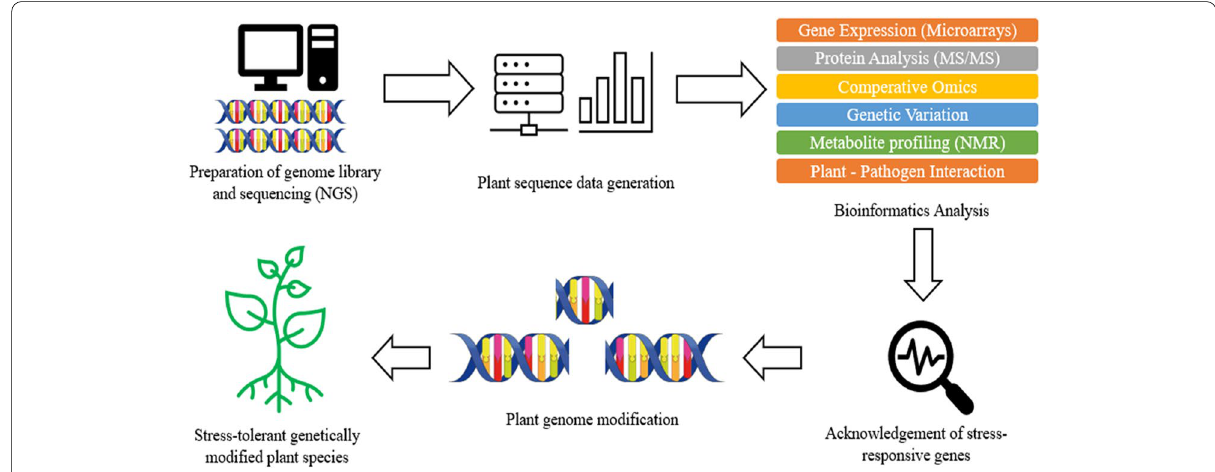
Fig. 2 Brief process involved in producing stress-resistant plant using bioinformatics